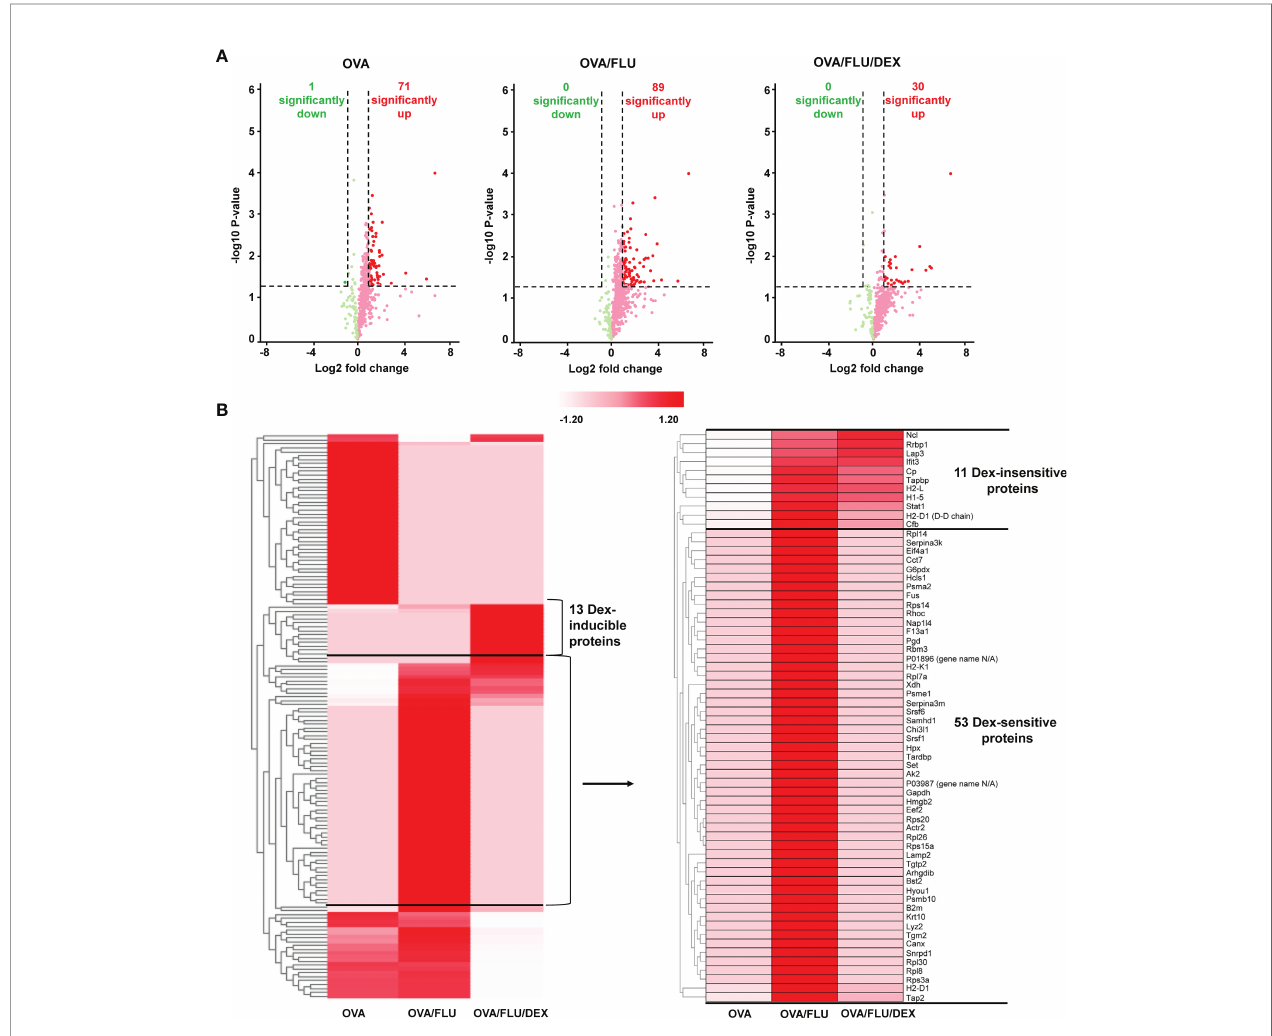
FIGURE 2 | Pro fi ling the mouse lung tissue proteome in allergic asthma and steroid-resistant asthma exacerbation. All samples were analyzed in biological duplicates and data presented are compared to PBS control. (A) Volcano plots represent protein changes in the lungs of all asthmatic mice (OVA or OVA/FLU or OVA/FLU/DEX). The x and y axes are in log scale. Dark red dots indicate signi fi cantly upregulated proteins whereas dark green dots indicate signi fi cantly downregulated proteins (threshold: protein fold change (asthmatic versus PBS ≥ 2 or ≤ -2, p-value ≤ 0.05). (B) Heatmap depicting expression of the signi fi cantly changed proteins in asthmatic mouse lung tissue compared to PBS controls (asthmatic versus PBS ≥ 2 or ≤ -2, p-value ≤ 0.05). Clustering analysis using Z-score for row scale normalization and Euclidean method for distance and aggregation. The heatmap shows a segment of proteins over-expressed exclusively in OVA/FLU/ DEX mice (DEX inducible proteins) and a segment of proteins over-expressed in OVA/FLU treated mice but under-expressed in OVA mice. One cluster of proteins was also found highly expressed in OVA/FLU/DEX treated mice (DEX-insensitive) while another cluster of proteins was not